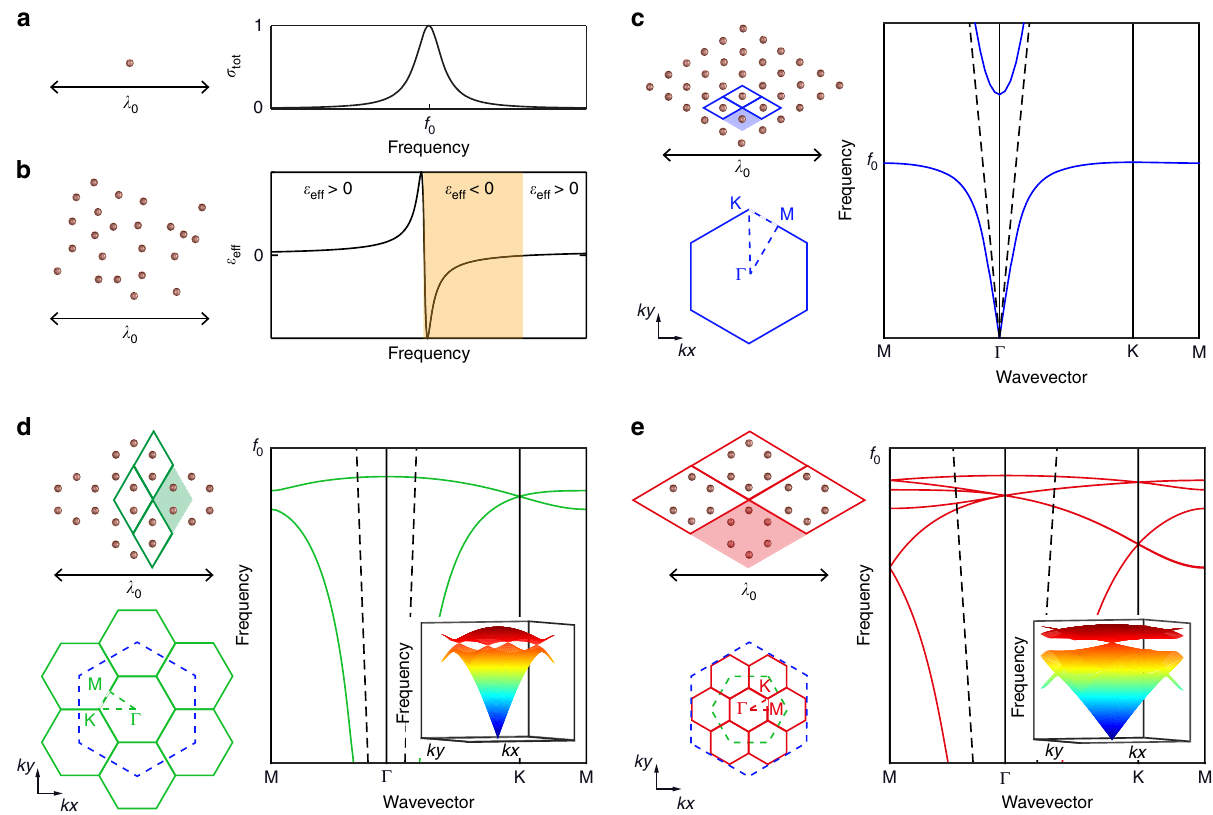
Figure 1 | Subwavelength band structure engineering in resonant metamaterials. ( a ) A subwavelength resonator and its scattering cross-section. ( b ) A dense two-dimensional ensemble of subwavelength resonators with arbitrary structure makes a metamaterial with negative permittivity (orange band) after the individual resonance of the resonators. Here the resonators are quarter wavelength copper rods sitting on a ground plane. ( c ) By adding a periodic subwavelength structure, in the form of a triangular array, such a metamaterial can acquire crystalline properties, involving a Bloch band structure with typical polaritonic dispersion corresponding to subwavelength bound modes localized to the array of rods. ( d ) More complex crystalline properties can be obtained, including point Dirac degeneracy at K point, by considering the polaritons supported by a honeycomb metamaterial. ( e ) Same lattice as c but viewed in the extended unit cell picture, allowing for mathematical folding of two time-reversed Dirac cones at the G point. These two time-reversed degenerate states are exploited here as the equivalent of Kramers pairs to induce topological properties at the subwavelength